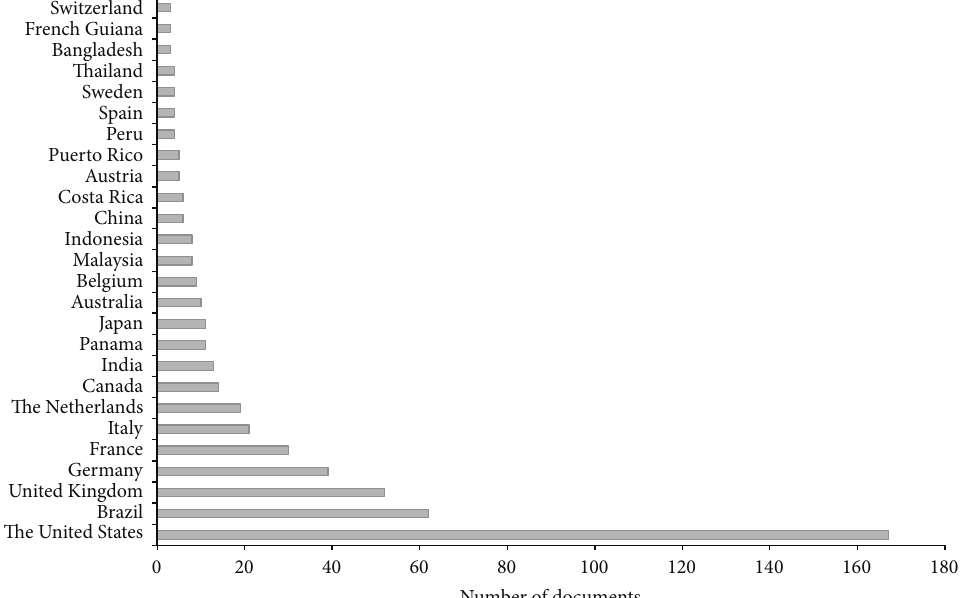
Figure 2: Number of articles published by author’s countries. The countries included in the figure have more than two publications, considering our search criteria.